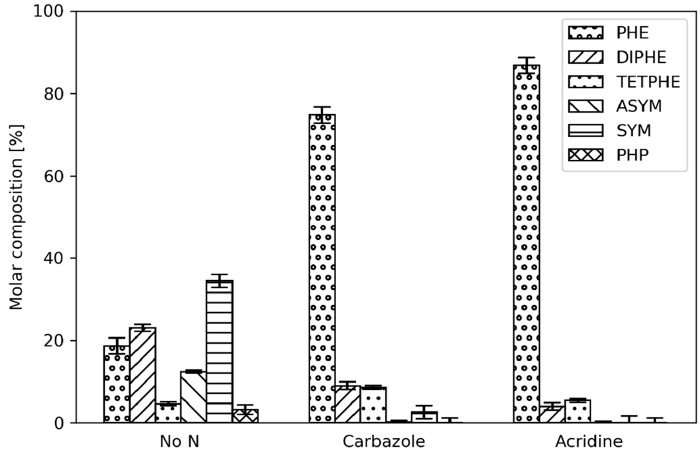
Figure 3. Phenanthrene product distribution with 1.2 mmol/dm 3 organic nitrogen (carbazole or acridine) present in the reactant feed at a reactor temperature of 280 °C.